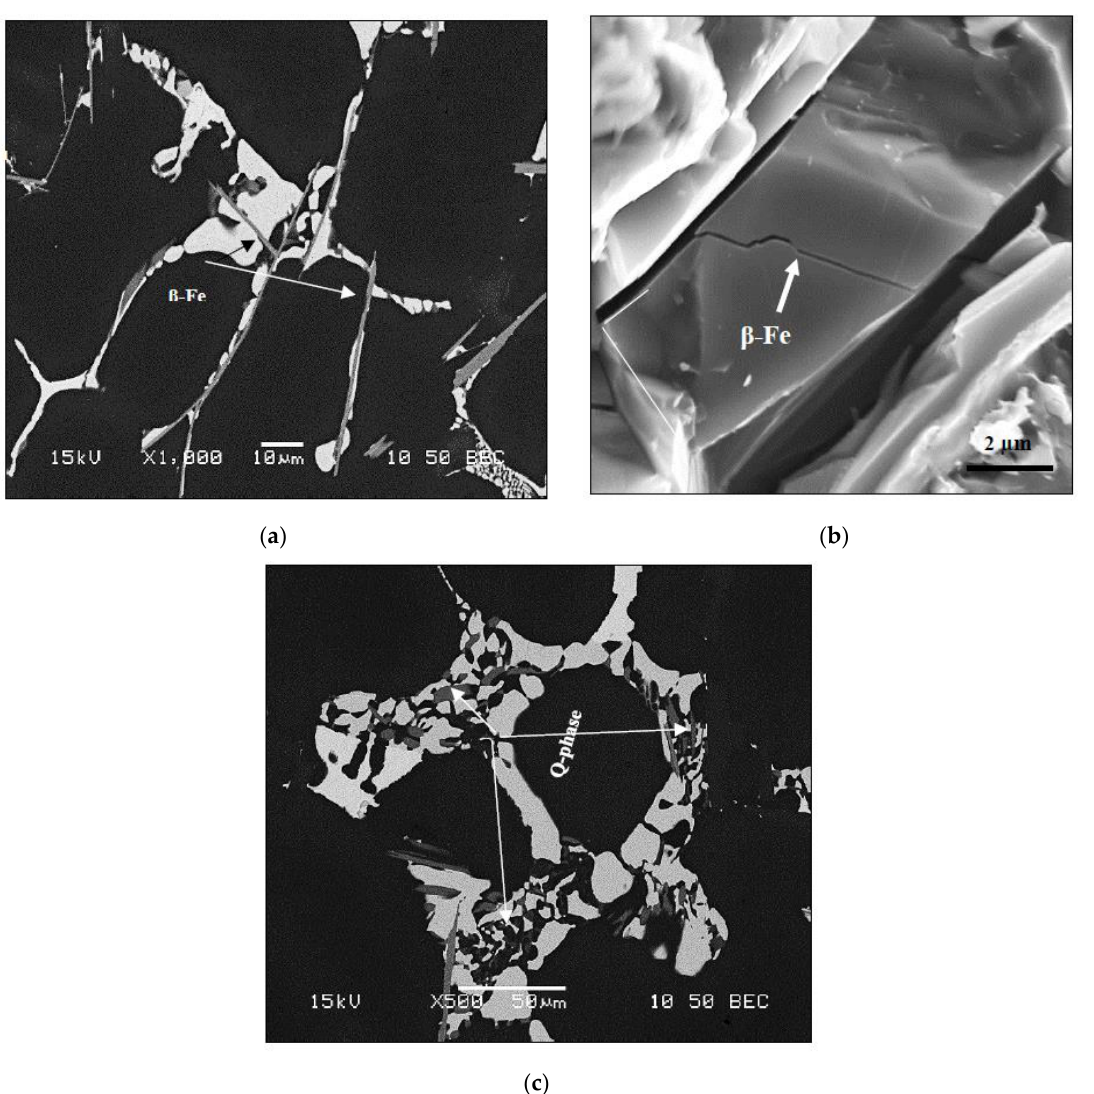
Figure 8. Backscattered electron images viewed from alloy A (0.35 °C/s) in the as-cast condition, showing ( a ) β -Fe phase platelets existing with massive Al 2 Cu particles; ( b ) fracture of a β -platelet; ( c ) particles of Q-phase growing out of the (Al-Al 2 Cu) eutectic network.